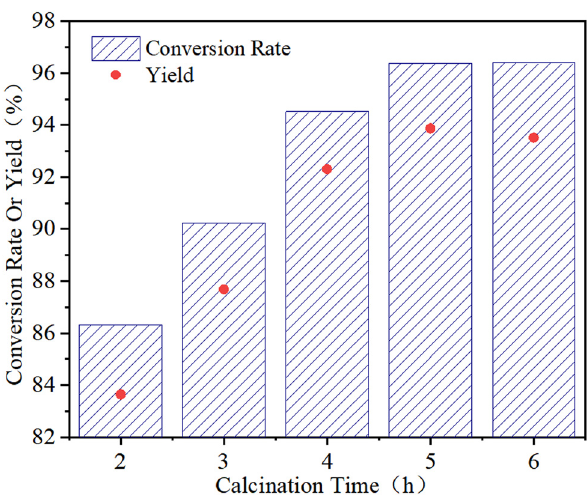
Figure 7: E ff ect of the calcination time on the catalytic performance of Fe – Sn – O.